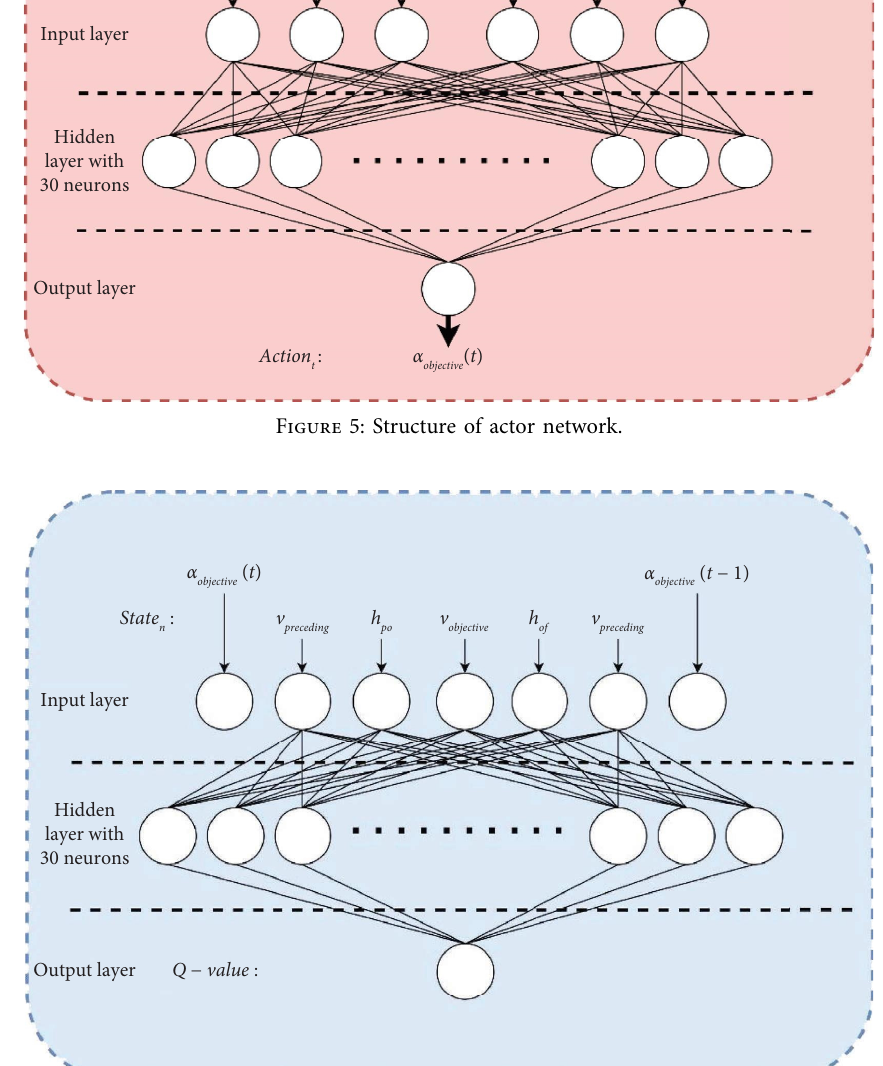
Figure 6: Structure of critic